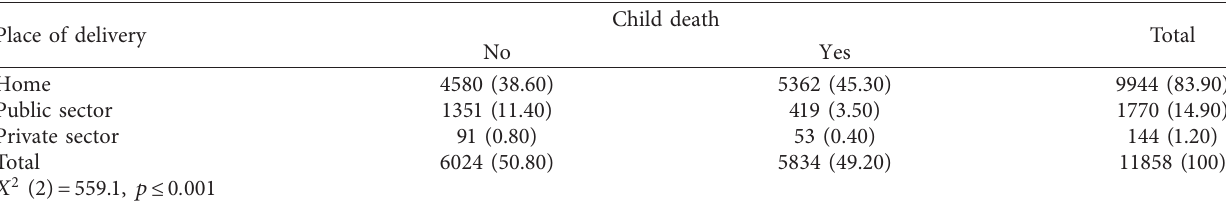
Table 5: Place of delivery on child mortality.